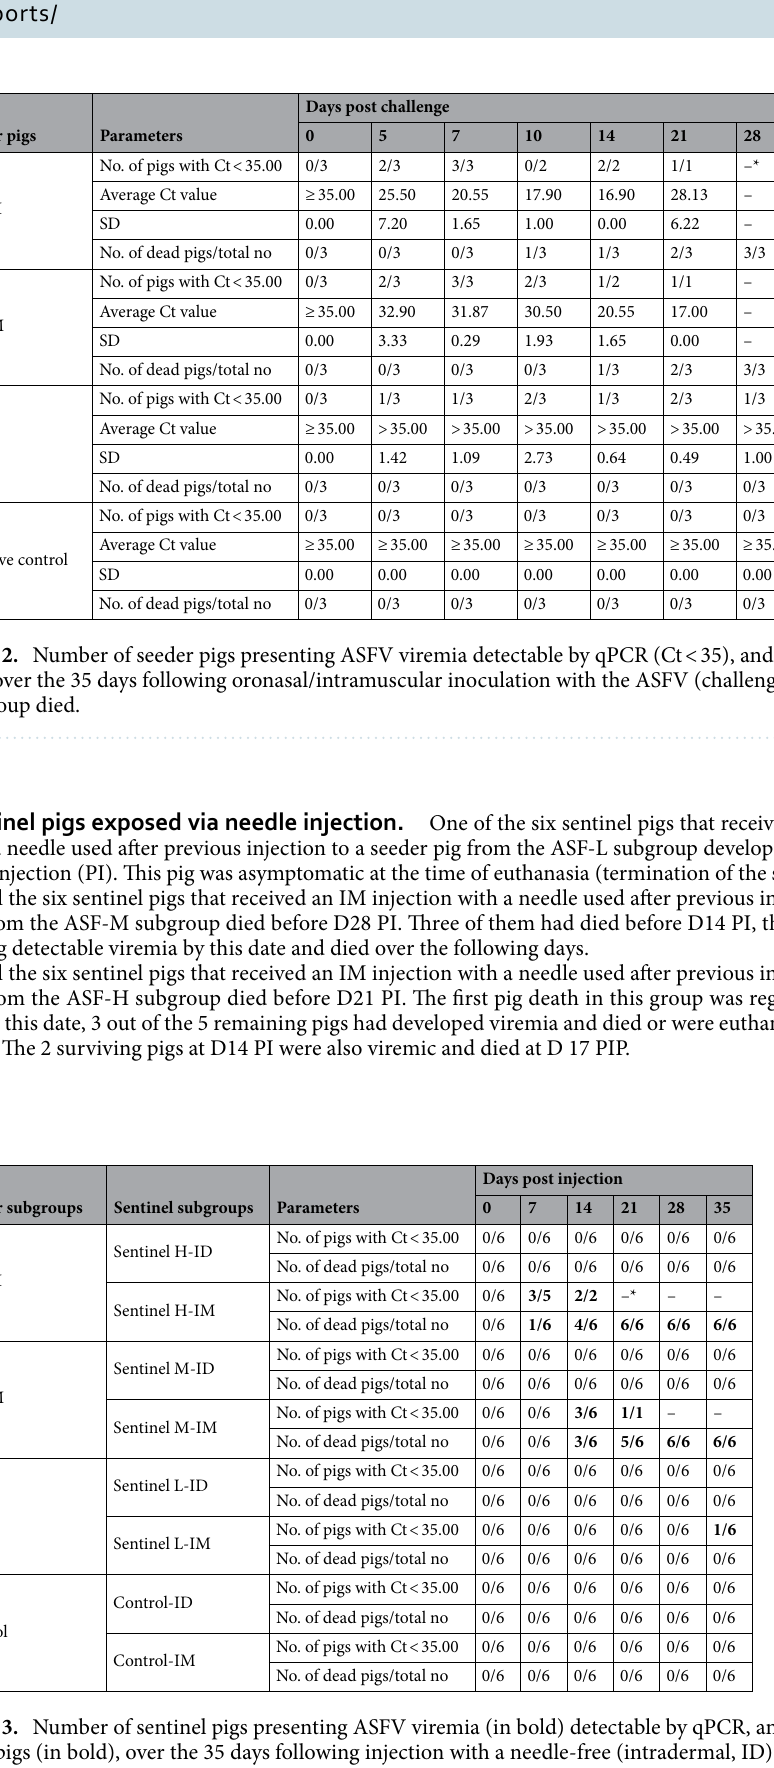
Table 3. Number of sentinel pigs presenting ASFV viremia (in bold) detectable by qPCR, and number of dead pigs (in bold), over the 35 days following injection with a needle-free (intradermal, ID) or a needle (intramuscular, IM) device previously used in a viremic seeder pig. *All pigs in the subgroup died.